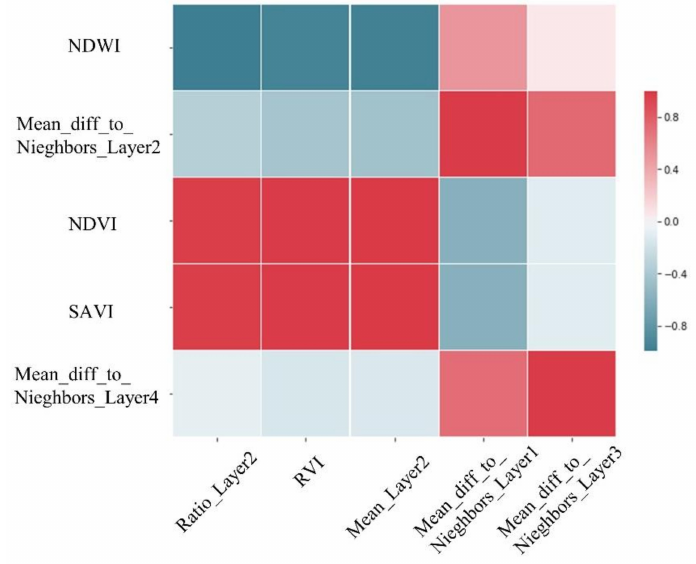
Figure 7. Thermodynamic chart of the five eliminated